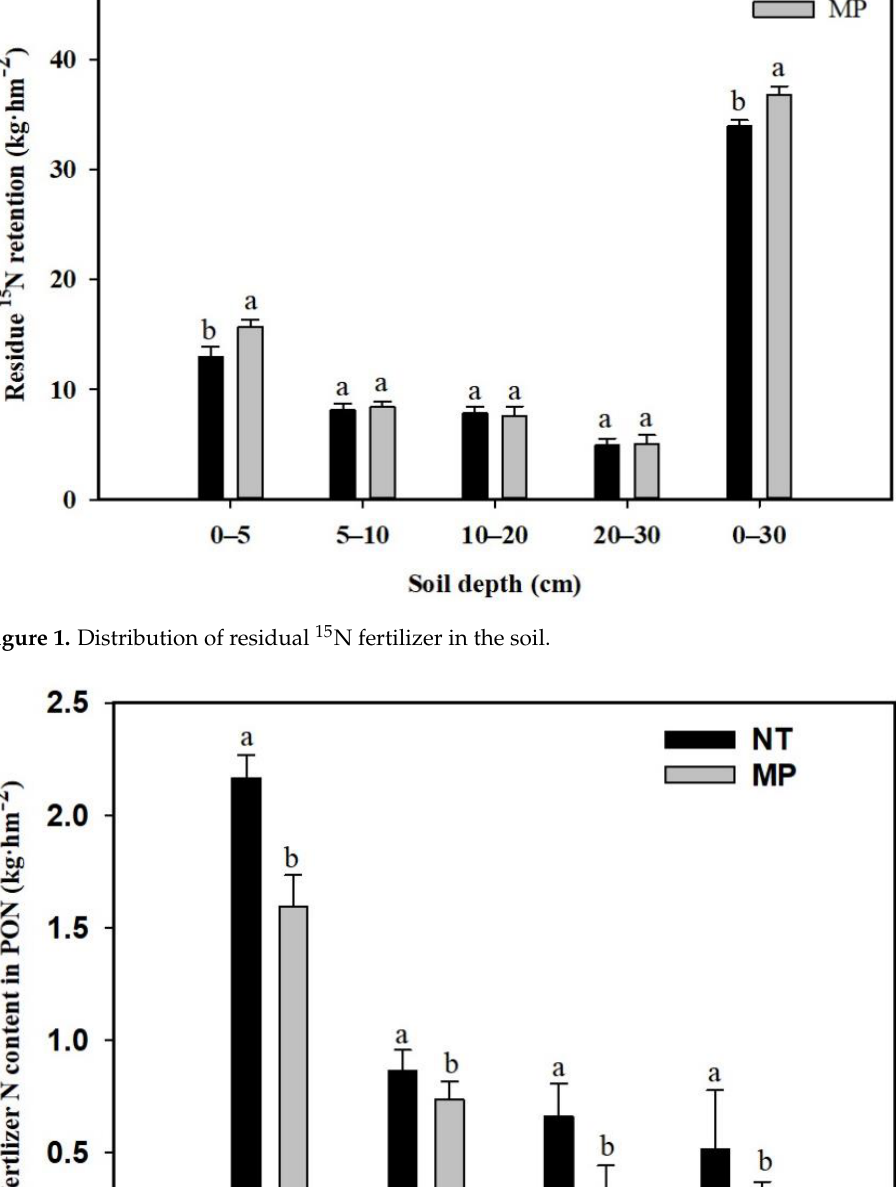
Figure 2. Depth distributions of fertilizer N in PON.